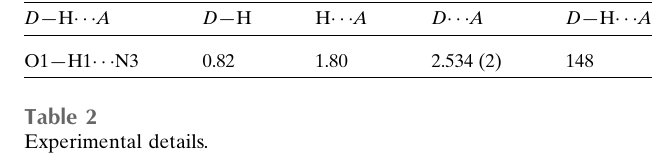
Table 1 Hydrogen-bond geometry (A˚ , (cid:3) ).